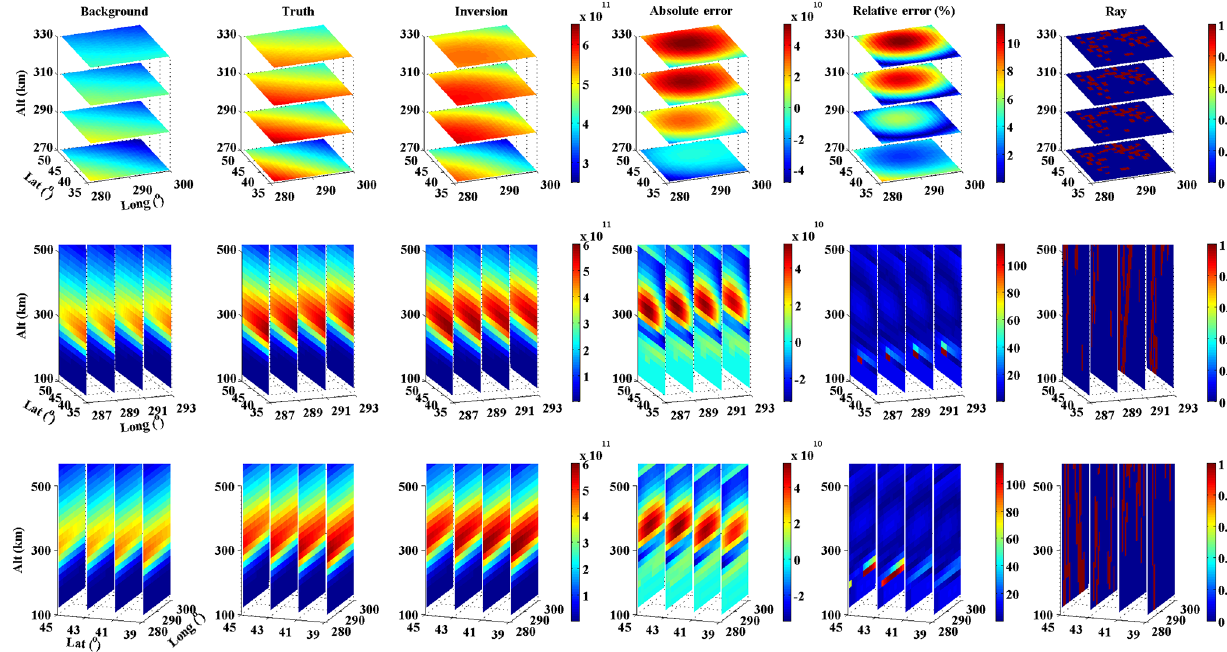
Figure 7. The reconstruction results using regularization method II under background I conditions. From top to bottom are the latitude- longitude slices at different altitudes, altitude–latitude slices at different longitudes, and longitude–altitude slices at different longitudes. From left to right are the background electron density, true electron density, reconstructed electron density, reconstructed absolute error, reconstructed relative error, and whether the satellite-receiver ray propagates through the corresponding grid or not.